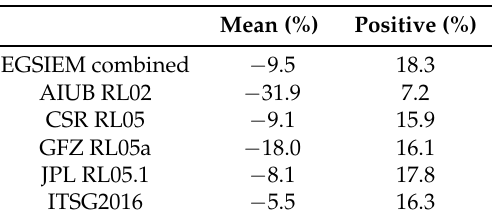
Table 4. Mean and positive Standard Deviation (STD) reductions between six GRACE products and the in-situ ocean bottom pressure time series.